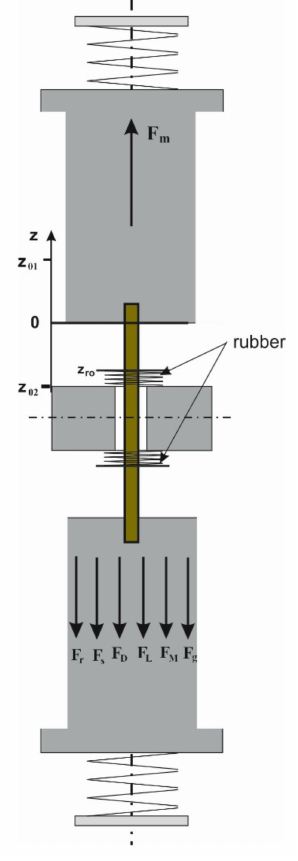
Figure 8. Scheme of the motor’s mechanical